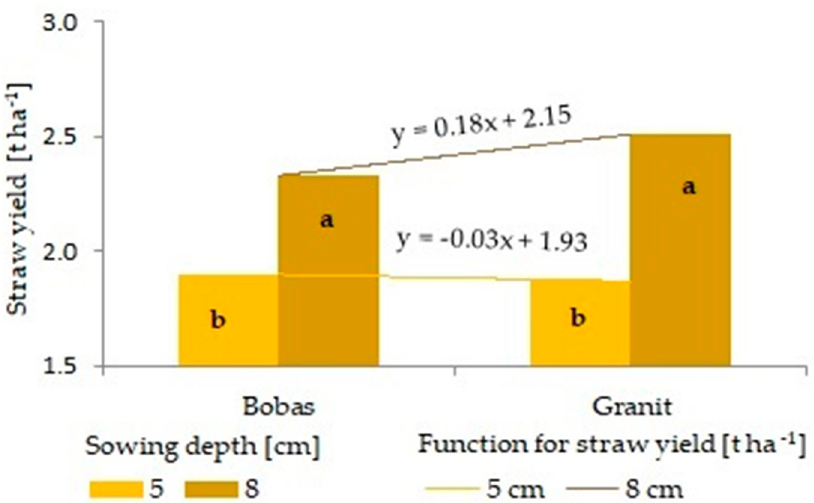
Figure 12. Straw yield in 2013 (SDH × C). Different letters indicate significant differences between factors (Tukey’s multiple range test). Straw yield increased with deeper placement of seeds (8 cm) in all range of seeding rate. The highest straw yield was gained while using the most dense seeds at 1 m 2 sown 8 cm deep (Figure 13).